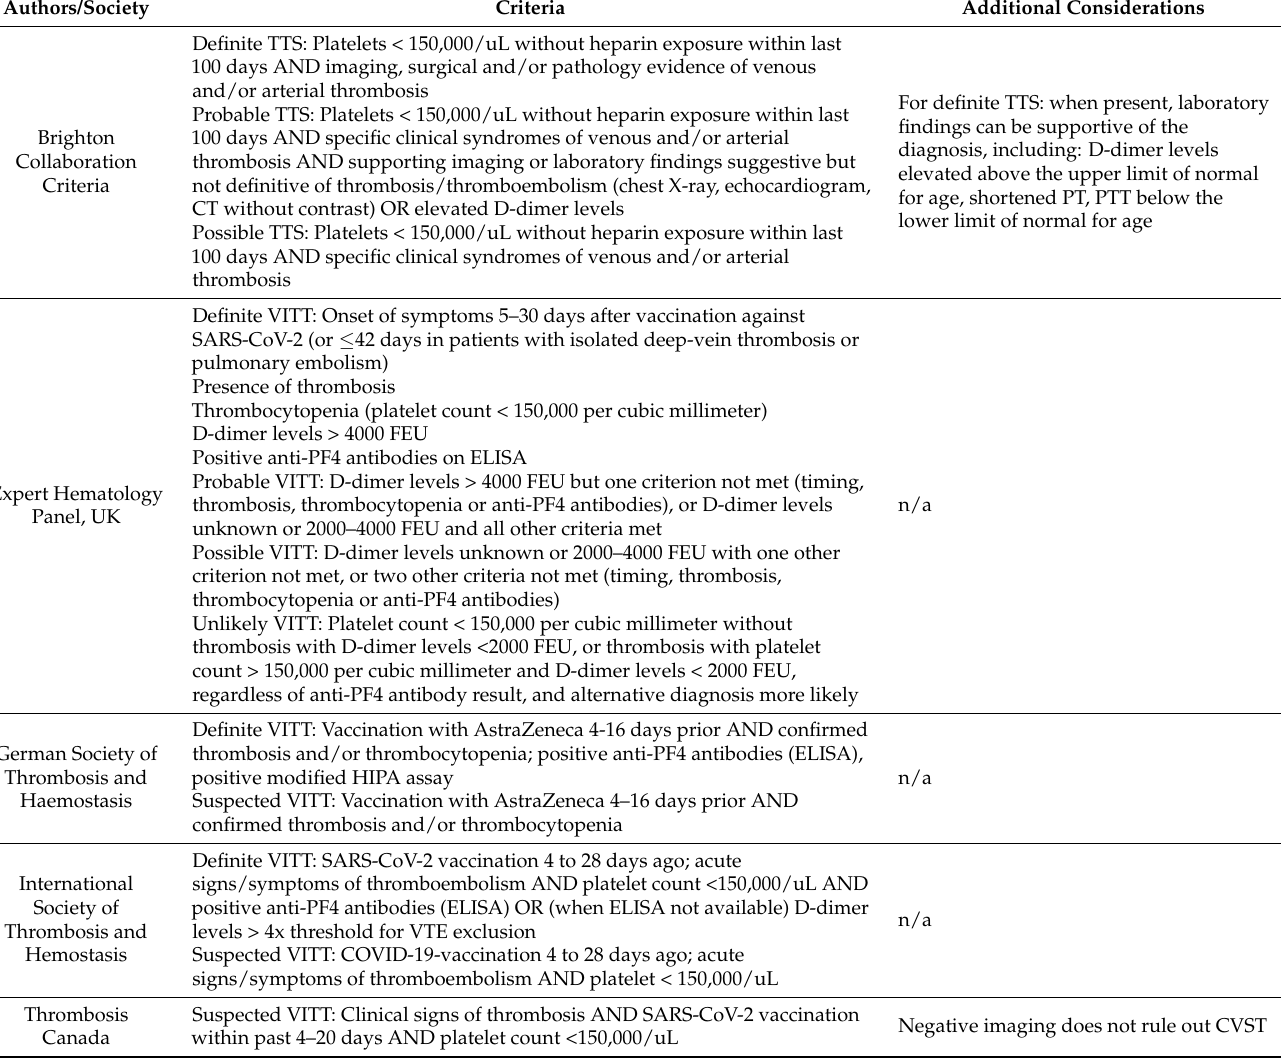
Table 1. Case-definition criteria according to different specialized